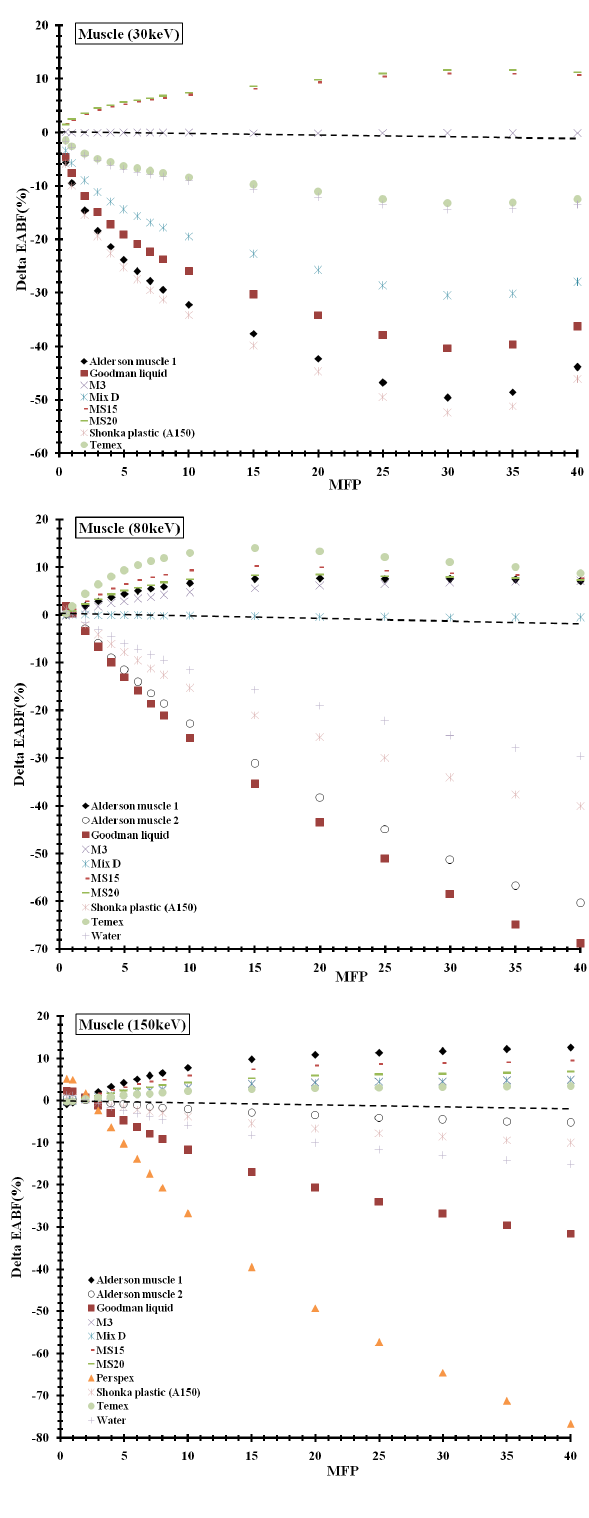
Figure 11. Relative deviation of energy absorption buildup factor of substitute materials to muscle tissue as a function of: ( left side) photon energy for fixed depths of 0.5, 15 and 40 mfp and ( right side) depth for fixed photon energy of 30, 80 and 150